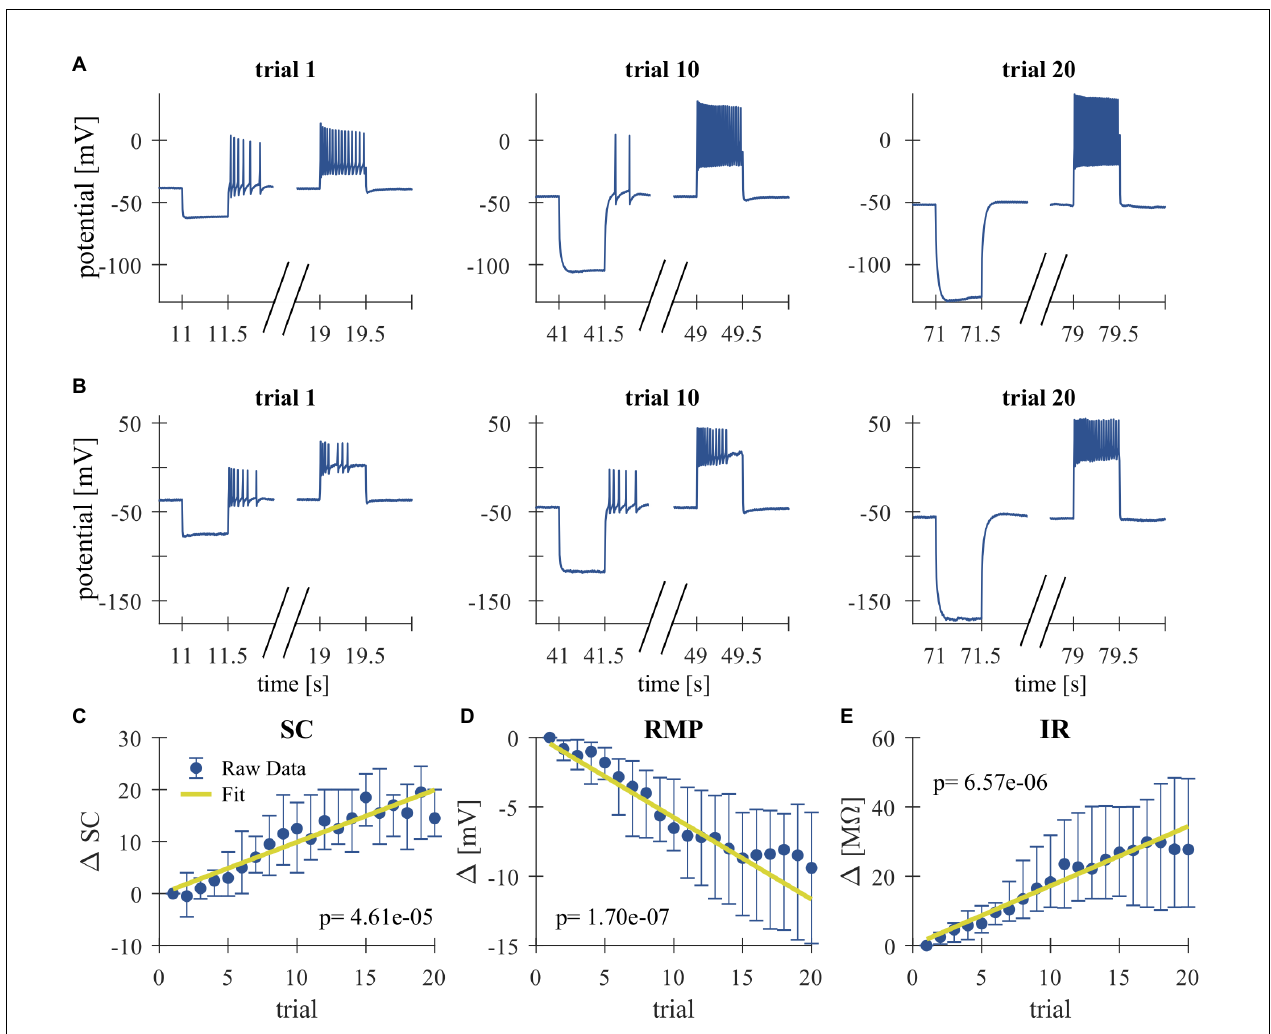
FIGURE 2 | Repeated somatic current injection effects physiological properties of T cells. (A,B) Representative responses of intracellularly recorded T cells to a 500 ms long somatic current pulse injection of –1 nA (seconds 11–11.5, 41–41.5, and 71–71.5), which was used for the calculation of the IR and often elicited rebound spikes, and +1 nA (seconds 19–19.5, 49–49.5, and 79–79.5) in Trial 1, 10, 20. (A) Example of a slowly adapting initial response, (B) Example of a rapidly adapting initial response. (C–E) Dependencies of changes in response parameters on trial repetitions shown as median and quartiles of all T cells ( N = 20). Linear fits were calculated for each cell individually and the obtained slopes were tested to differ significantly from 0 ( t -test, α = 0.05, p -values given in the panels). The yellow line indicates the average of the fits for all cells. (C) Spike count (SC) difference from first trial (absolute number). (D) Resting membrane potential (RMP) difference from first trial (mV). (E) Input resistance difference from first trial (M (cid:127)